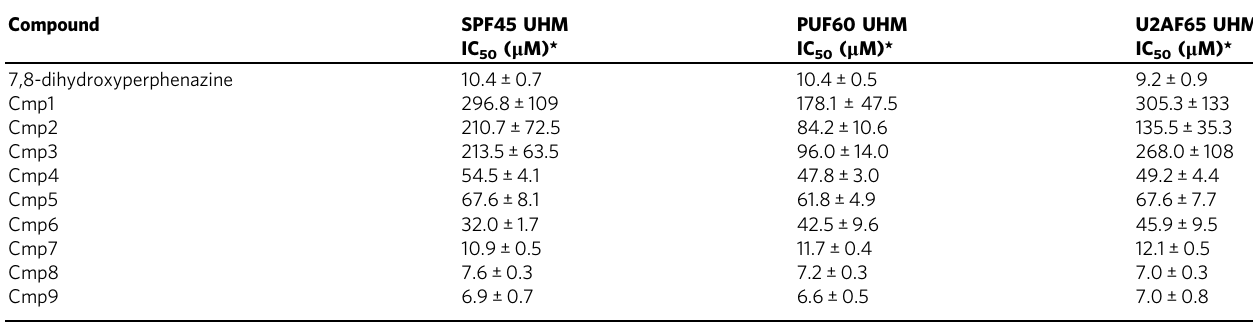
*Errors represent standard errors of fi